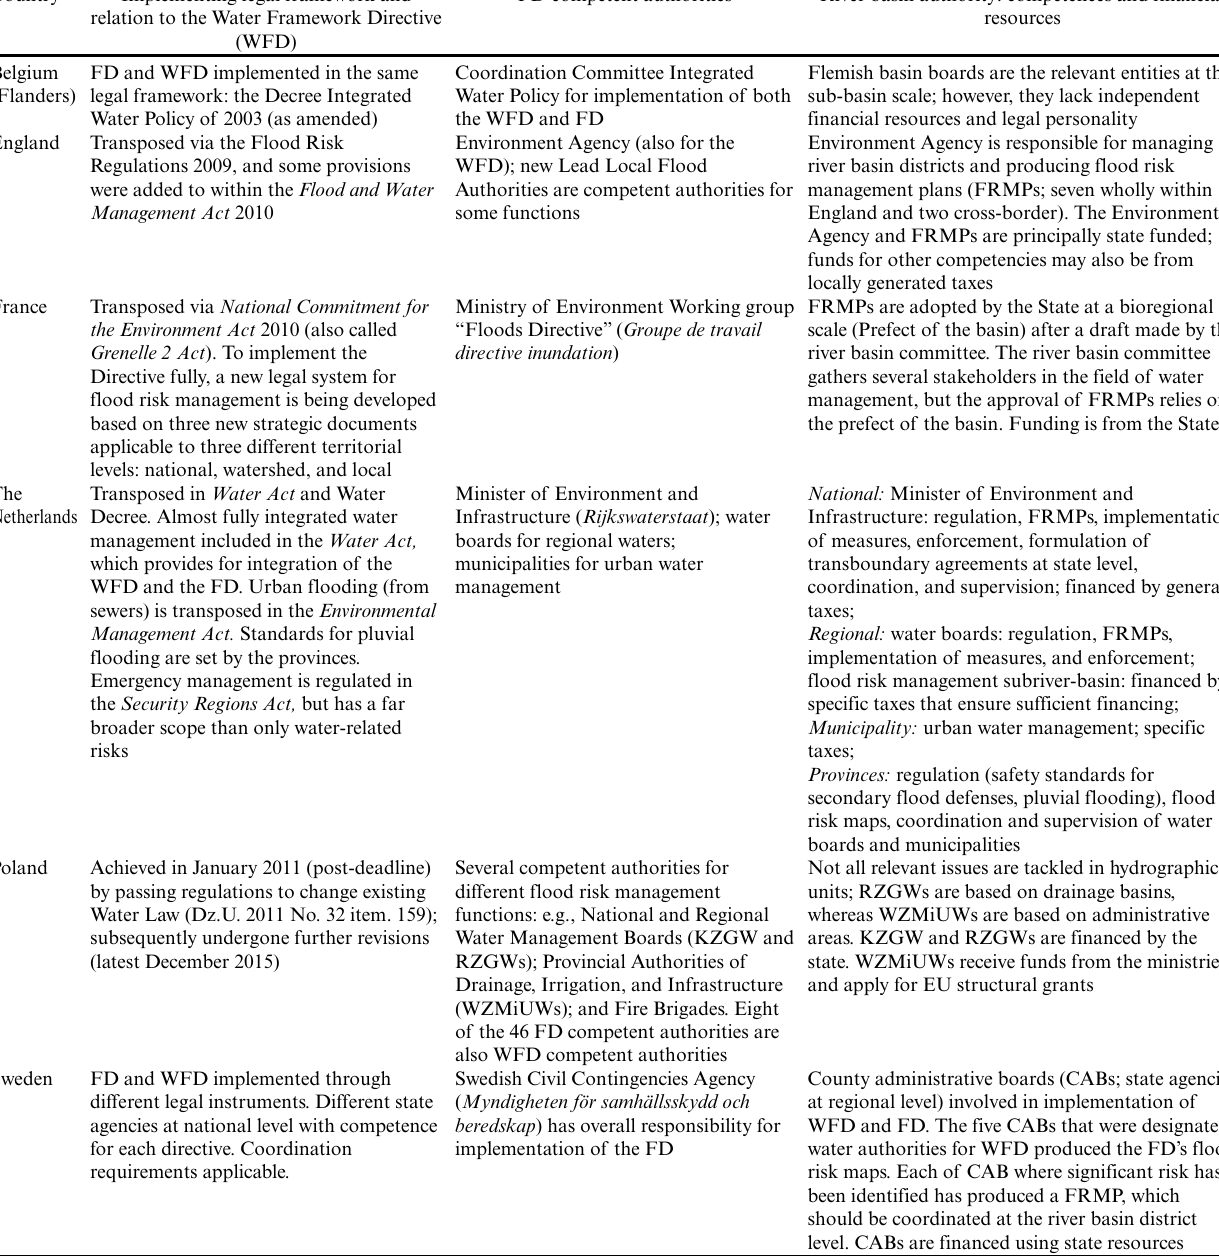
Table 2. General overview of the implementation of the Floods Directive (FD) in selected countries.